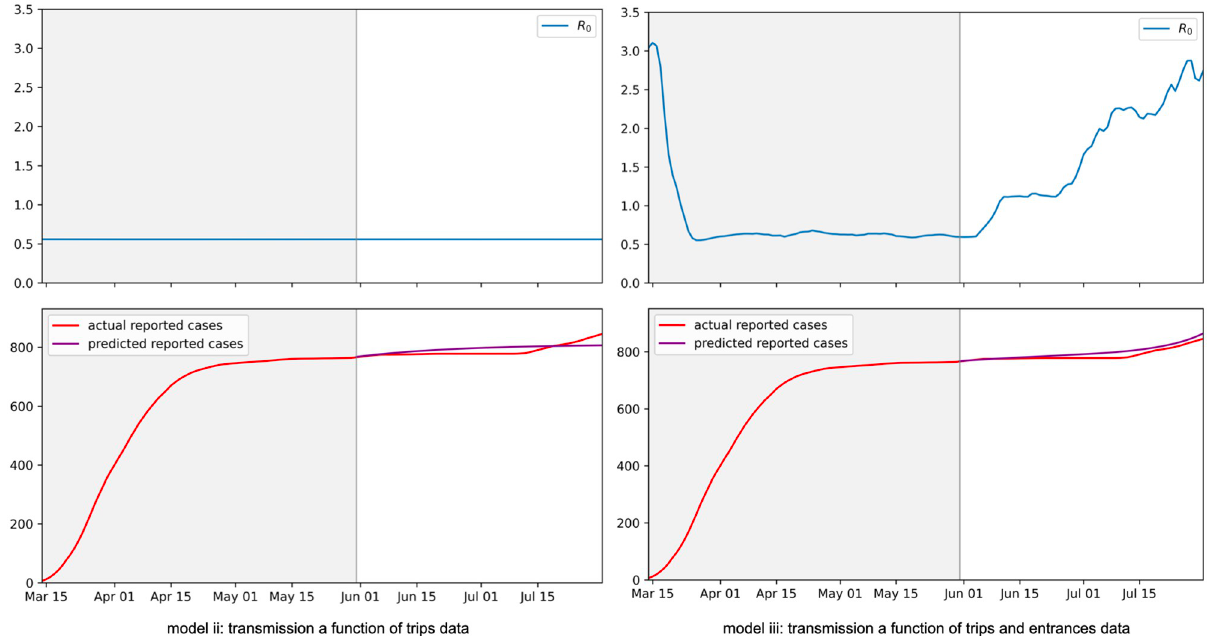
Fig 4. Fit model results. Time series values for (top) the estimated R 0 and (bottom) actual versus predicted reported cases that resulted from model training. Left: Plotted values for the model which uses just trips data. Right: Plotted values for the model which uses both trips and entrances data. Models were trained over the period March 14—May 31 and tested over the weeks that followed. The training and testing periods are divided by gray and white backgrounds, respectively. Axes for the R 0 values are set to highlight that values were flattened for the trips data model. See Fig A.5 in S1 Appendix for plots that show the full variation in the R 0